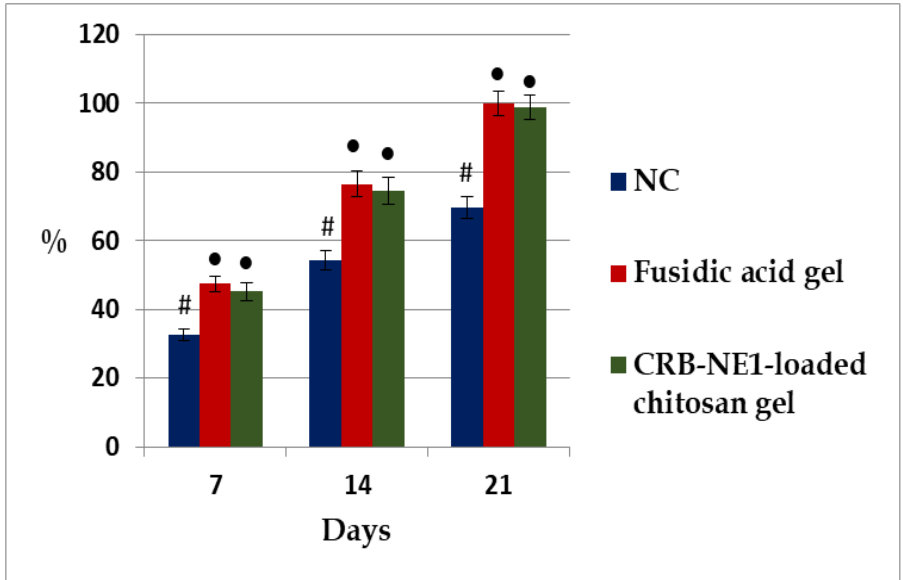
Figure 7. Percentages of wound contractions at different time intervals in excision wound model in rats. Values are expressed as mean ±S.E.M., n = 6 rats/group. ● indicates significance compared to NC group at p < 0.05. # indicates significance compared to fusidic acid gel group at p < 0.05. Table 2. Effect of the reference fusidic acid gel and the CRB-NE1-loaded chitosan gel on the epithe- lialization periods in rat’s wounds.